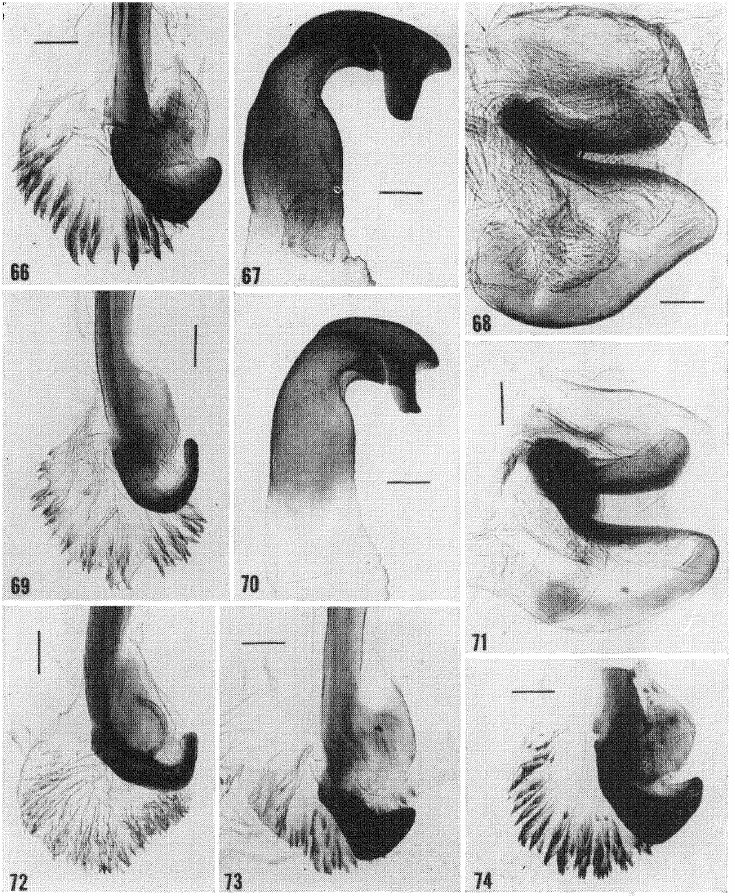
Figs. 66-74. 66-68. (19 MCZ). Eublaberus losticus. (Type 16074 of Blabera ]emorata Seudder). Napo or Marafi6n. 69-71. (27 AMNH). Eublaberus distanti. Moyobamba, San Martin, Peru. (det. Roth). 72. (N). Eublaberus distanti. Trinidad. (det. Roth). 73. (N.) Eublaberus losticus. Panama. (det. Roth). 74. (4 BMNH). Eublaberus sp. Para, Brazil. (det. Roth). (scale 0,3